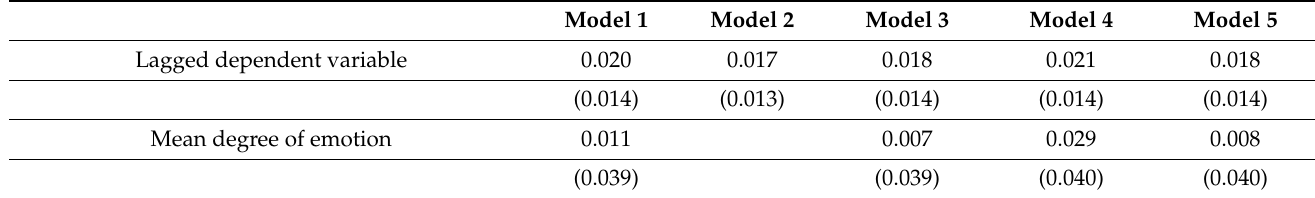
Table 7. Tense emotion